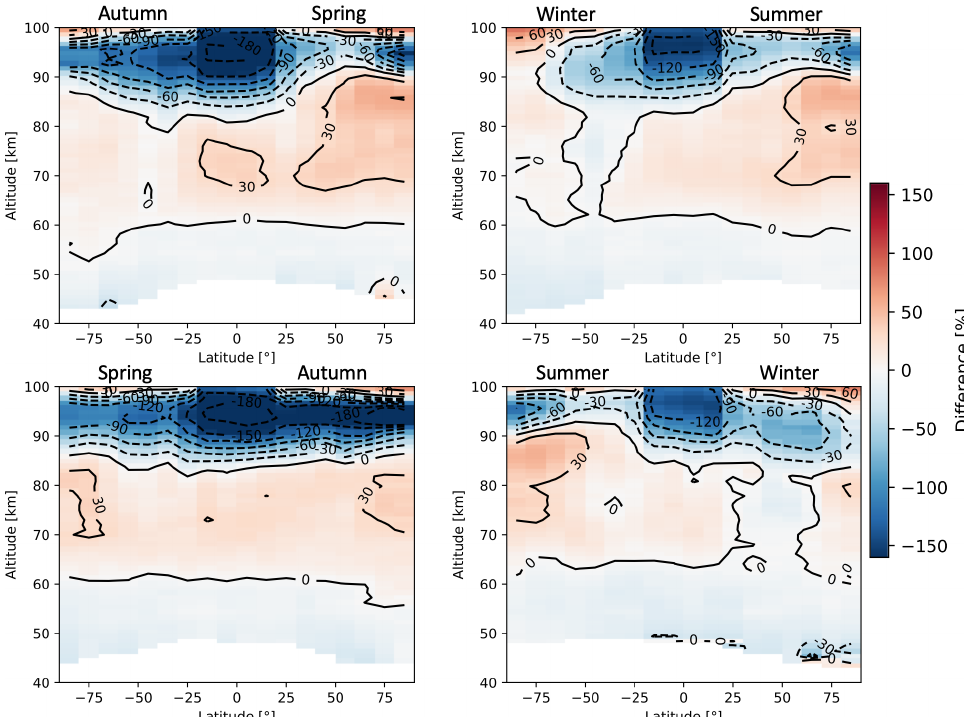
Figure A12. Seasonal zonal means of H 2 O FM13 SMR–MIPAS middle atmosphere relative differences averaged over the time period indicated in Table 2. The seasons are intended as astronomical seasons, i.e. each starting at the respective solstice or